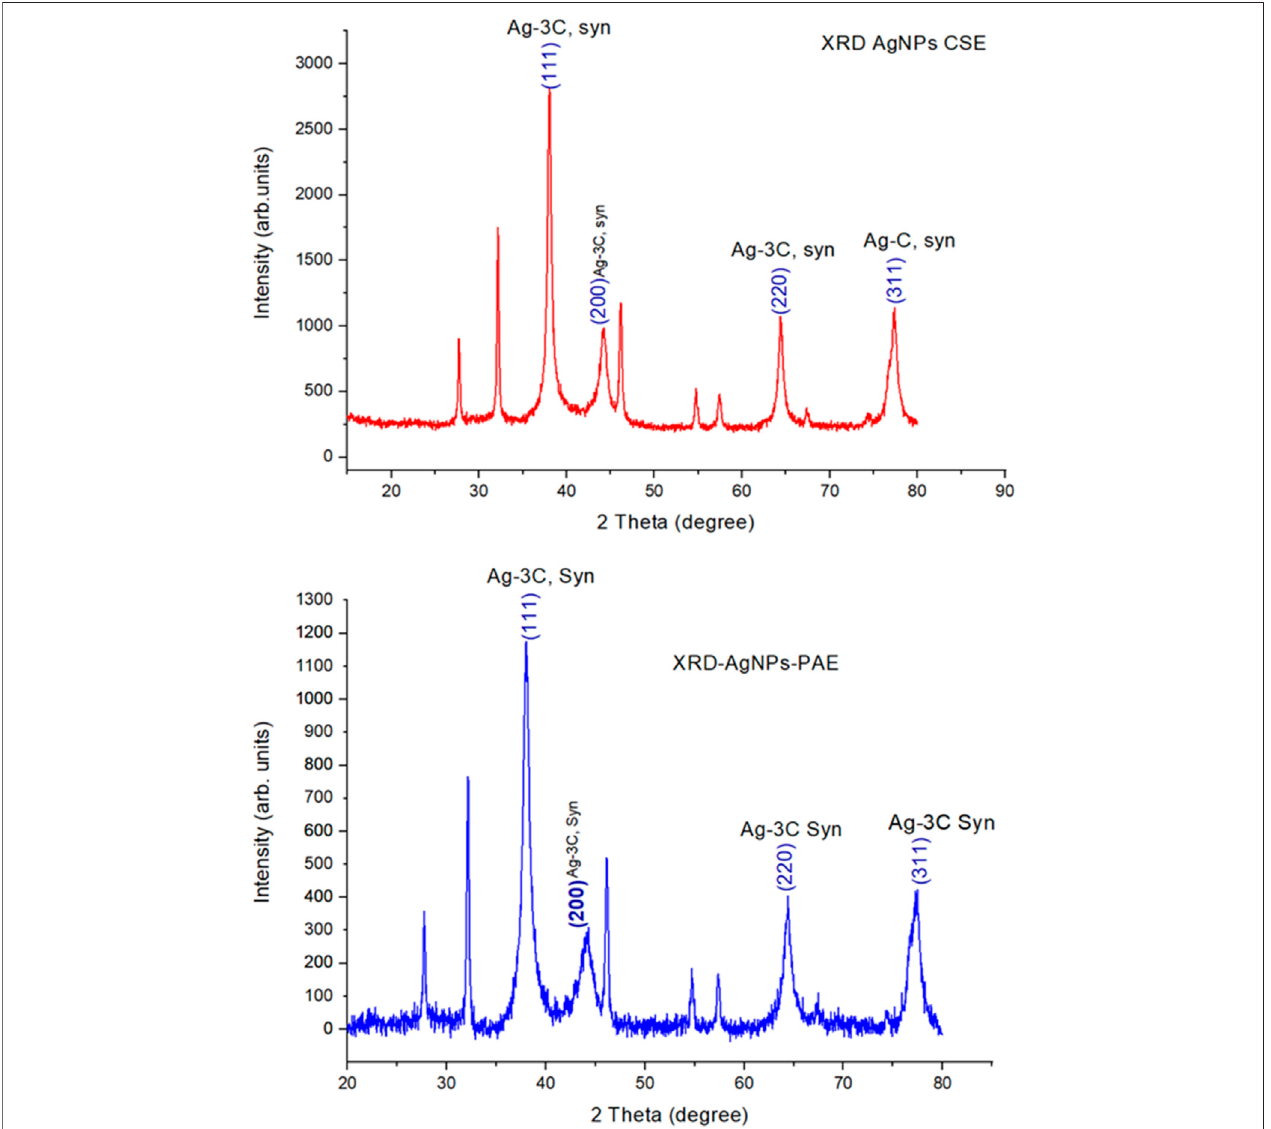
FIGURE 7 | XRD pattern for green-synthesized